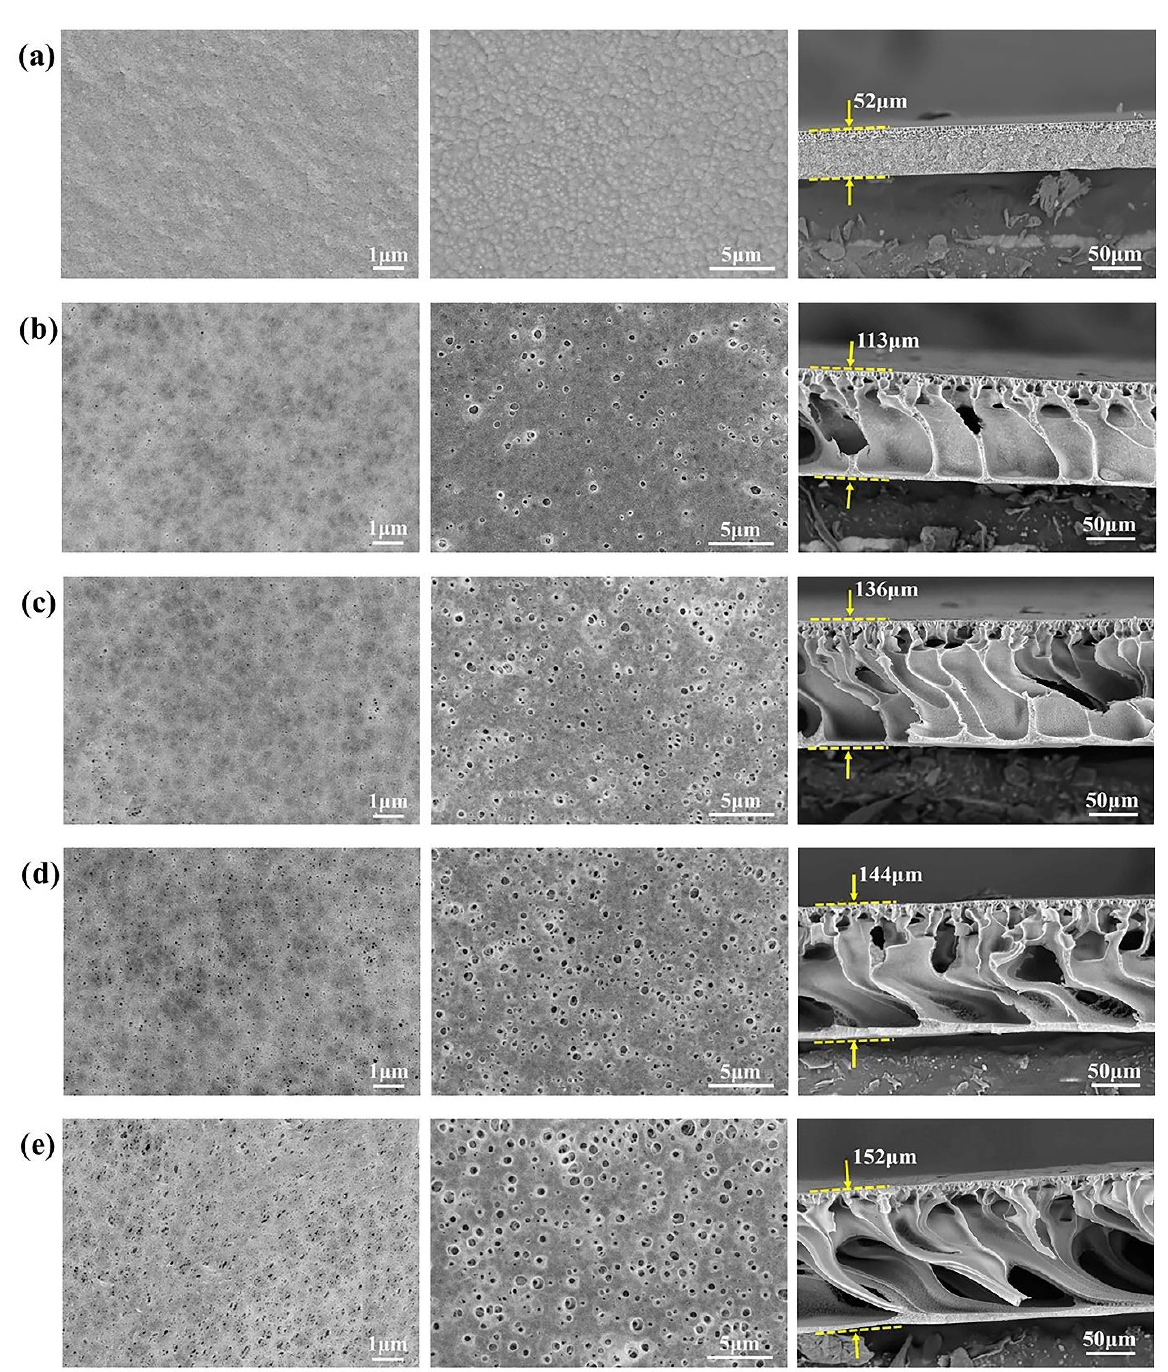
Figure 3. FE-SEM micrographs from the top, bottom, and cross-section of various membranes at three different scales of 1, 5, and 50 μm: ( a ) M-0, ( b ) M-1, ( c ) M-3, ( d ) M-5, and ( e ) M-7.